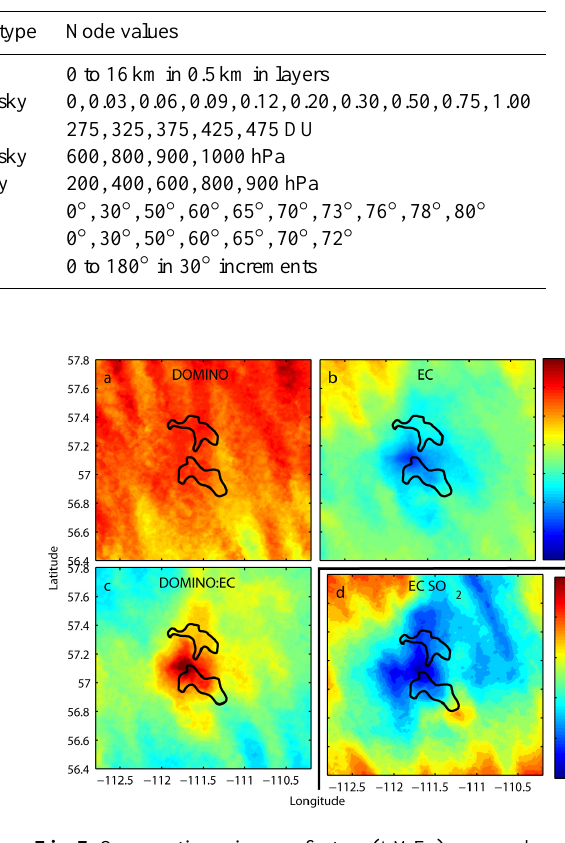
Fig. 7. Summertime air mass factors (AMFs) averaged over 2005– 2011: (a) from the DOMINOv2 data files; (b) EC-AMF; (c) the ratio of DOMINOv2:EC, which also represents the scaling that would be applied to the VCDs; and (d) EC SO 2 AMFs. The faint strip- ing pattern visible in each panel arises from differences in the OMI